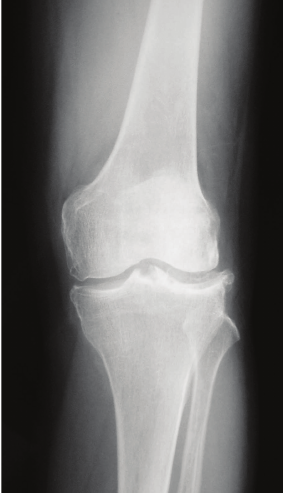
Figure 4: Radiograph of Case 2 . AP view shows grade 3 lateral- dominant osteoarthritis according to Kellgren and Lawrence scale.